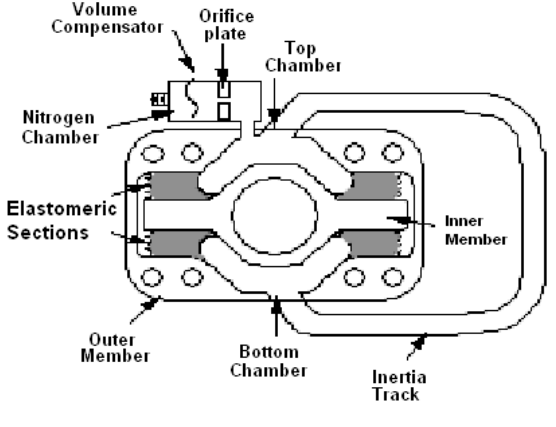
Fig. 4. A double pumper passive fluid mount.